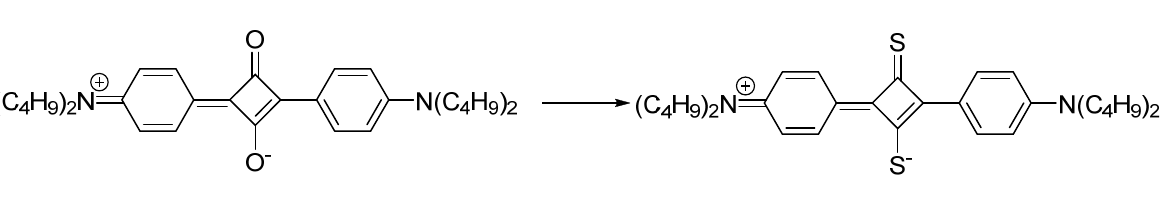
Figure 20. Modification of the squaraine system to increase 1 O 2 quantum